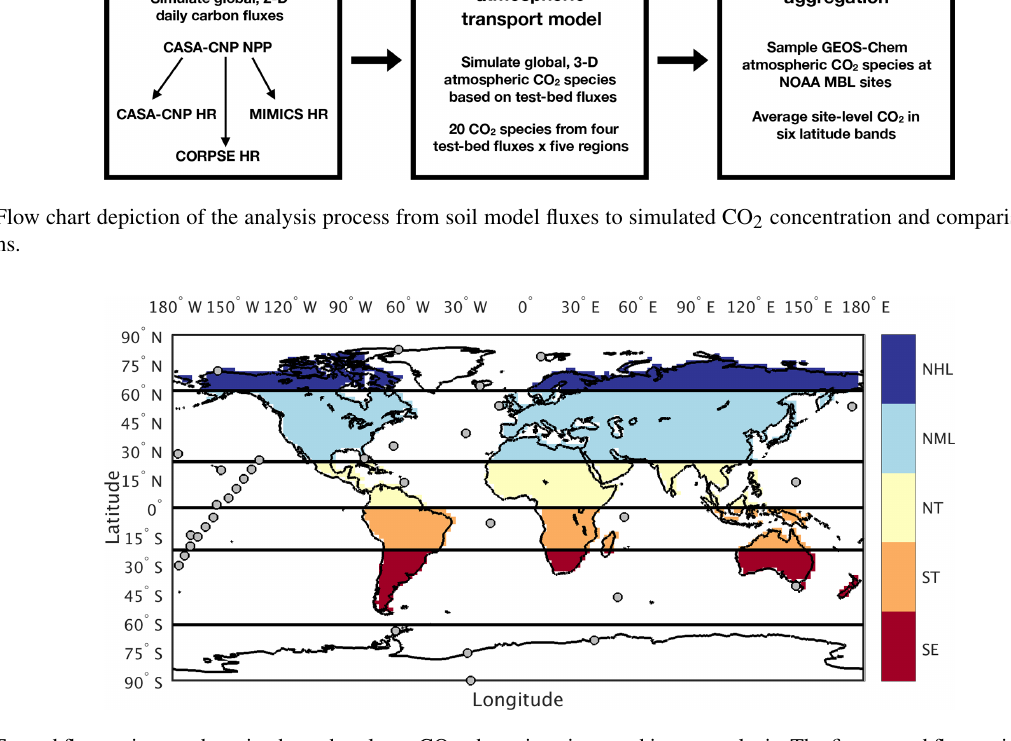
Figure 2. Tagged flux regions and marine boundary layer CO 2 observing sites used in our analysis. The five tagged flux regions are shown in color fill: northern high latitudes (NHL), northern midlatitudes (NML), northern tropics (NT), southern tropics (ST), and southern extratropics (SE). For sampling simulated CO 2 consistent with the tagged flux regions, we aggregate marine boundary layer sites (filled circles) into six latitude bands defined by the black